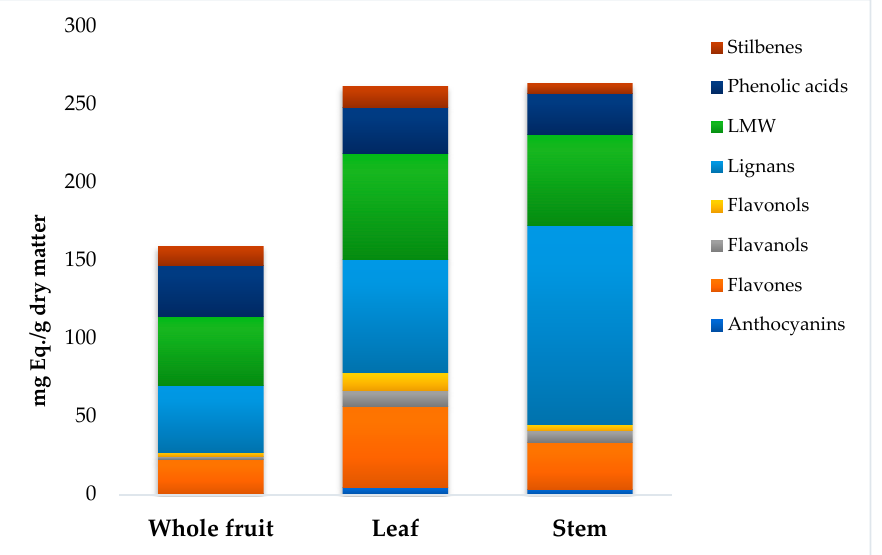
Figure 1. Cumulative phenolic content of Cydonia oblonga Mill. hydroalcoholic extracts (80% methanol), namely whole fruit, leaf, and stem. The semi-quantitative values are expressed as the mean of three replicates, mg Equivalent (Eq.)/g. LMW = lower-molecular-weight phenolics (i.e., as tyrosol